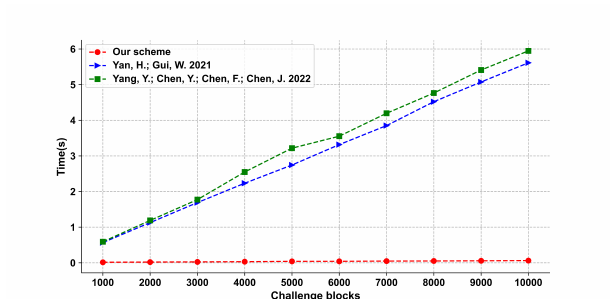
Figure 5. Computation cost of Proof Gen [21,38].